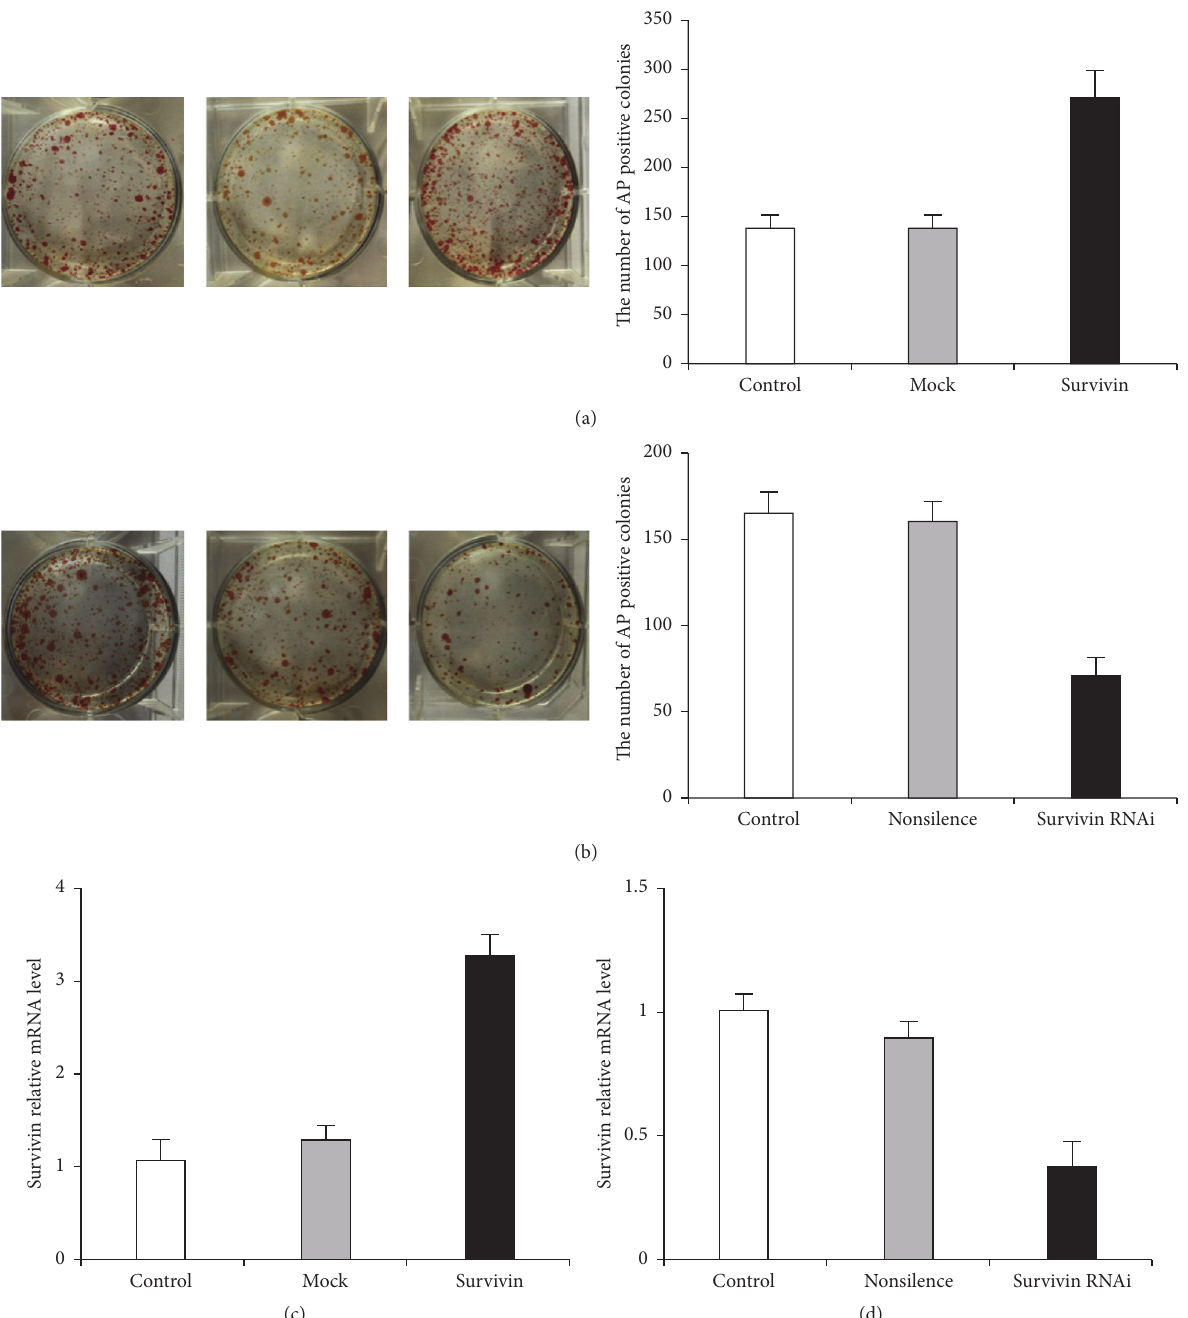
Figure 4: AP positive numbers in Survivin overexpression or Survivin knockdown in the reprogramming of NPCs. (a) AP positive numbers of 1F-OCT4, mock (vector control), and Survivin overexpression on 3.5 cm diameter well from the left to right; (b) AP positive numbers of 1F-OCT4, nonsilence, and Survivin-RNAi on the same size dishes (from the left to right). A representative experiment is shown in the left panels. Counting AP+ colonies in the same experiment, mean values + SD are shown in the right panels. (c) The relative expression of Survivin in mRNA